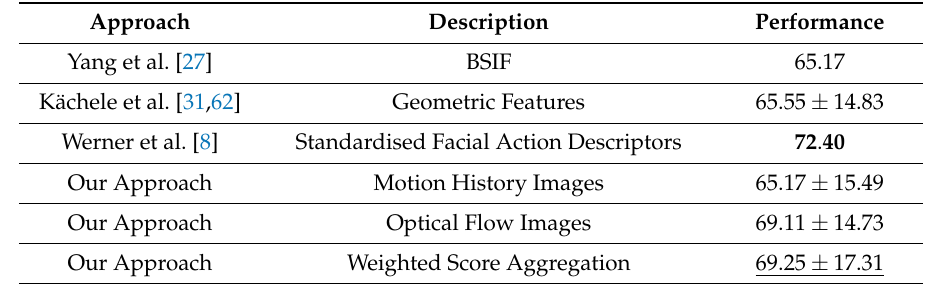
Table 3. Classification performance comparison to early works on the BioVid Heat Pain Database (Part A) in a LOSO cross-validation setting for the classification task T 0 vs . T 4 .